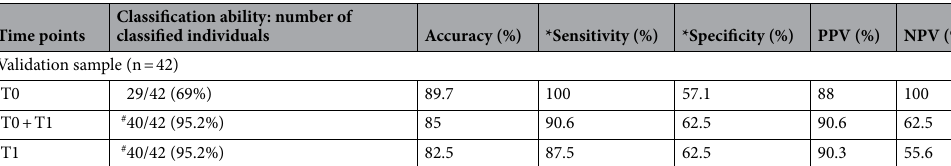
Table 3. Accuracy and classification ability of the approach adopted. *Computed with respect to classified subjects. # The two patients who were not classified belonged to the “shadow” area for the first evaluation (time < 86 days) and presented with missing values 4 months after the event (T1).